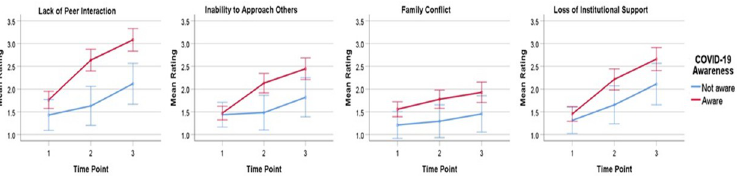
Fig 2. Line plots of estimated marginal means of the parent-rated child concern ratings. The plots show a significant linear change in the parent-rated child concerns about the lack of peer interaction and the loss of institutional support over time. The blue line represents children who were not aware of COVID-19, and the red line represents children who were aware of COVID-19. Error bars indicate 95% confidence intervals. Time point 1: Before COVID-19; Time point 2: At the start of COVID-19; Time point 3: During COVID-19 (at the time of survey completion).